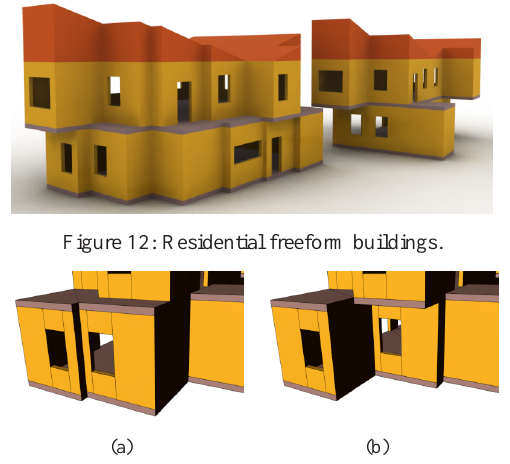
Figure 13: In the freeform residential buildings, the shape of a floor slab between storeys is influenced by both storeys.